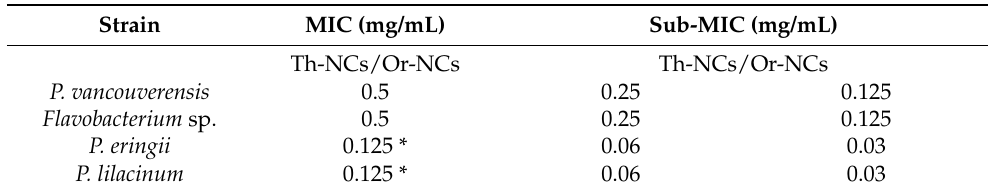
Table 1. MIC and sub-MIC values of EO-NCs against P. vancouverensis , Flavobacterium sp., P. eringii , P. lilacinum .